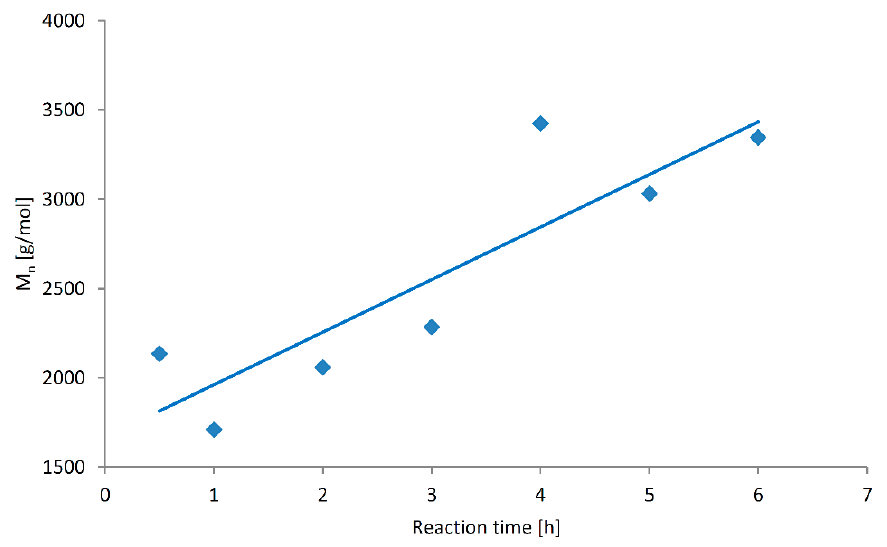
Figure 6. The relationship between the M n of PCEC and the reaction time.